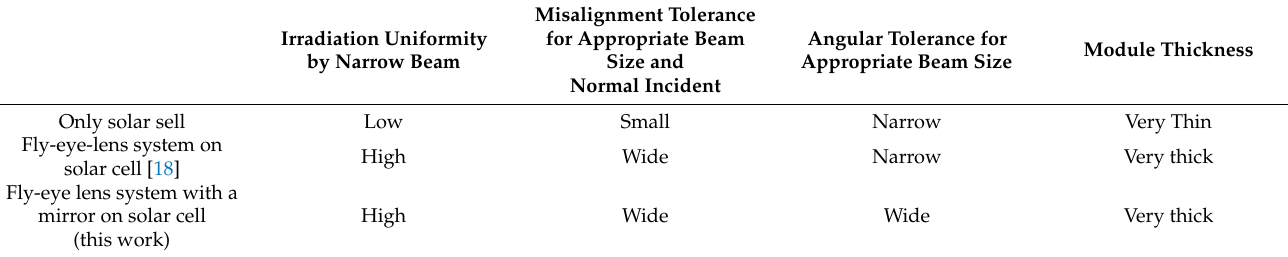
Table 1. Comparison of light-receiving